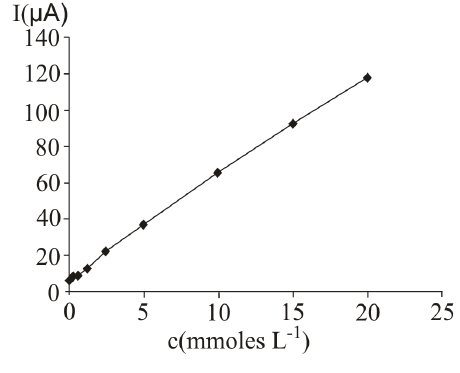
Figure 10. Calibration graph obtained obtained at ascorbic acid determination by cyclic voltammetry at a carbon paste working electrode; for experimental conditions see Figure